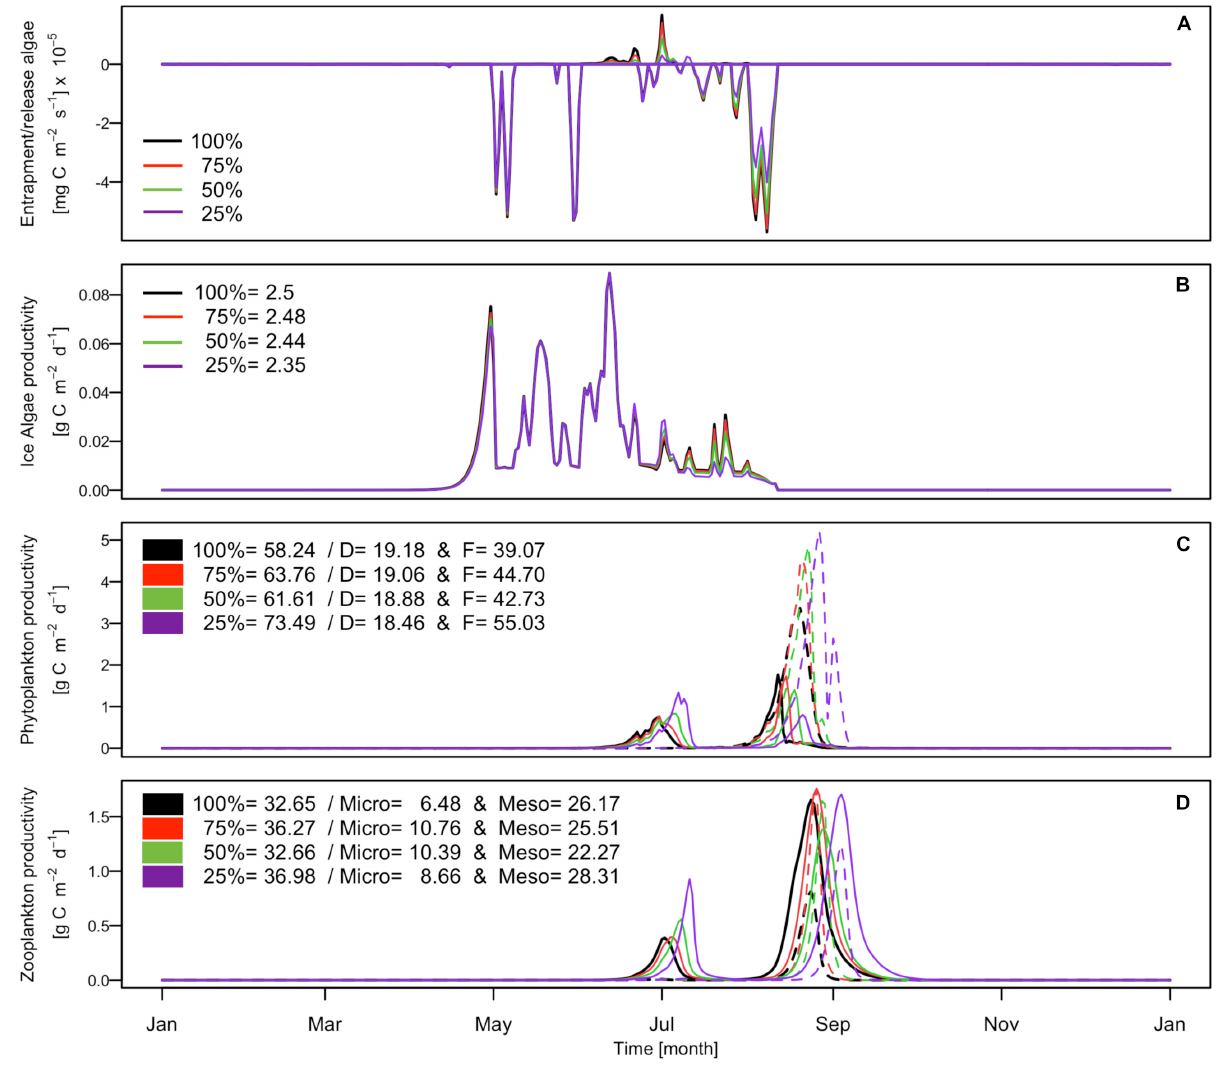
FIGURE 6 | Simulated time series of (A) diatoms/ice algae flux at the ice-ocean interface; (B) production rates of ice algae; (C) production rates of phytoplankton including diatoms (D: solid line) and flagellates (F: dashed line), and (D) production rates of zooplankton including mesozooplankton (Meso: solid line) and microzooplankton (Micro: dashed line). Black color presents result for the 100% experiment, red color for the 75% experiment, green color for the 50% experiment, and purple color the 25% experiment. In the legend (B–D) are indicated the annual production in gC m − 2 for ice algae, phytoplankton including diatoms production (D) and flagellates production (F) and zooplankton including microzooplankton (Micro) and mesozooplankton